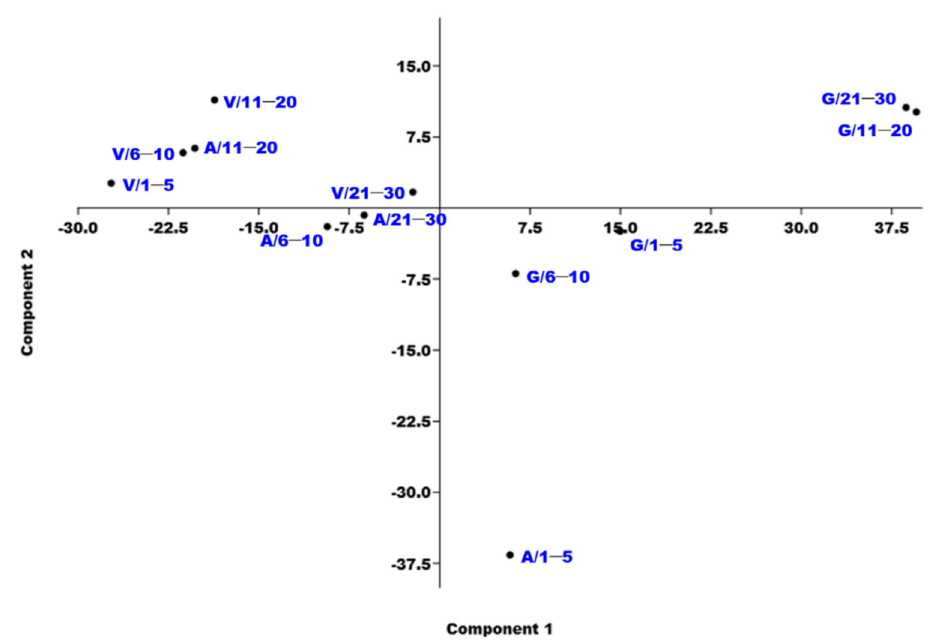
Figure 6. Result of the multivariate PCA analysis (V—vineyards, A—arable land,